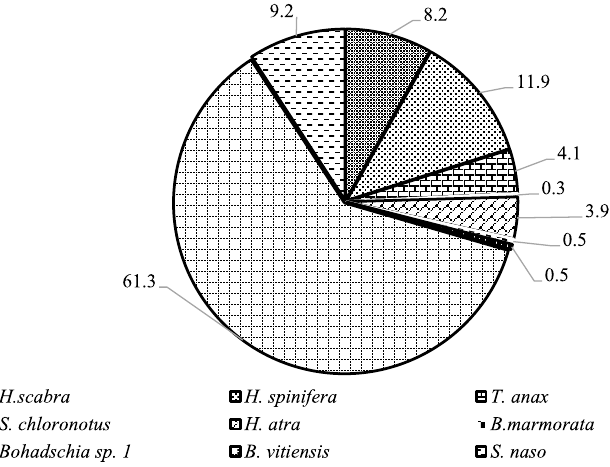
Fig. 2. Percentage contribution of each sea cucumber species to the total sea cucumber landings of north, north-west and north-east coasts of Sri Lanka from November 2015 to January